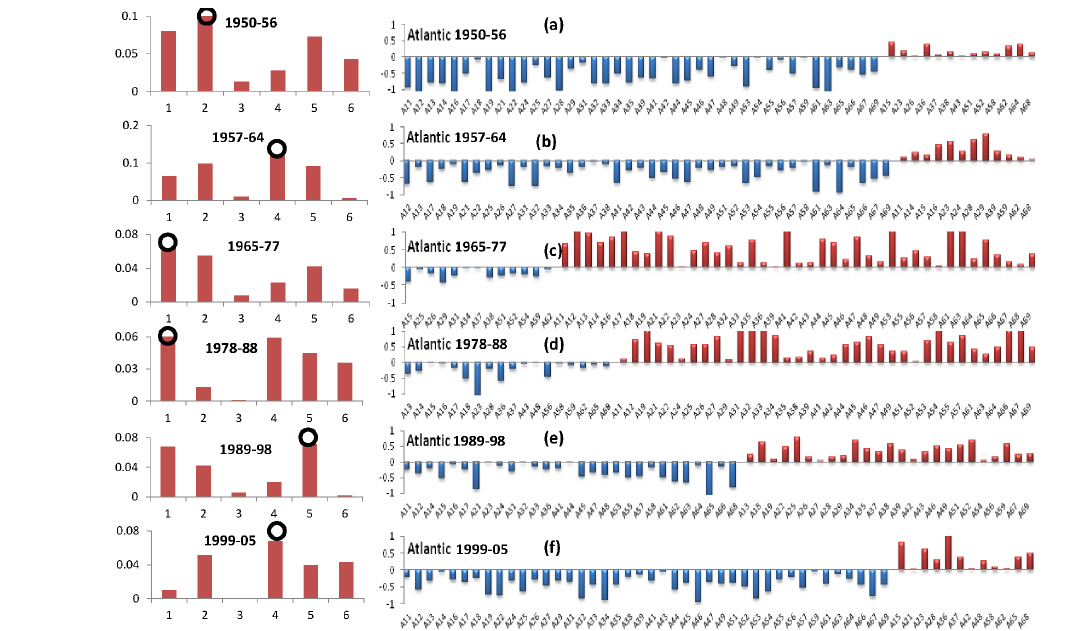
Figure 11. Atlantic Ocean. Left panel indicates the wave kinetic energy anomaly 1/2( u 2 (n) + v 2 (n) ) with wavenumber ( x axis). Right panel indicates the average normalized fish landings for the Pacific Ocean for each species in the periods coincident with abrupt climate regime shifts. (a) 1950–1956, (b) 1957–1964, (c) 1965–1977, (d) 1978–1988, (e) 1989–1998, and (f) 1999–2005. The x axis code number indicates both geographical ocean sub-region (shown in Fig. 1) and the FAO fish species category; the codes are summarized in Table A1 of the Appendix.